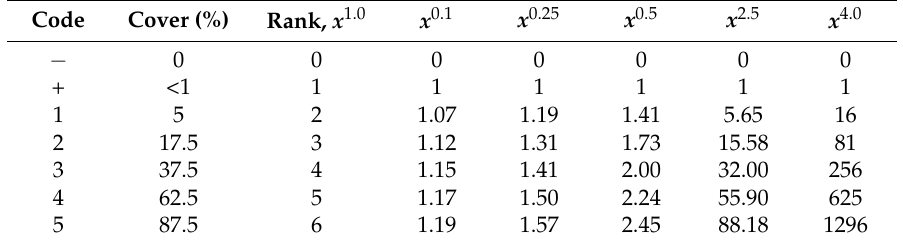
Table 1. Transforming cover-abundance values in vegetation ecology. x 1.0 is the vector of rank scores replacing the conventional code in column one. x (cid:48) = x 2.5 is approximating the cover percentage [9,20].